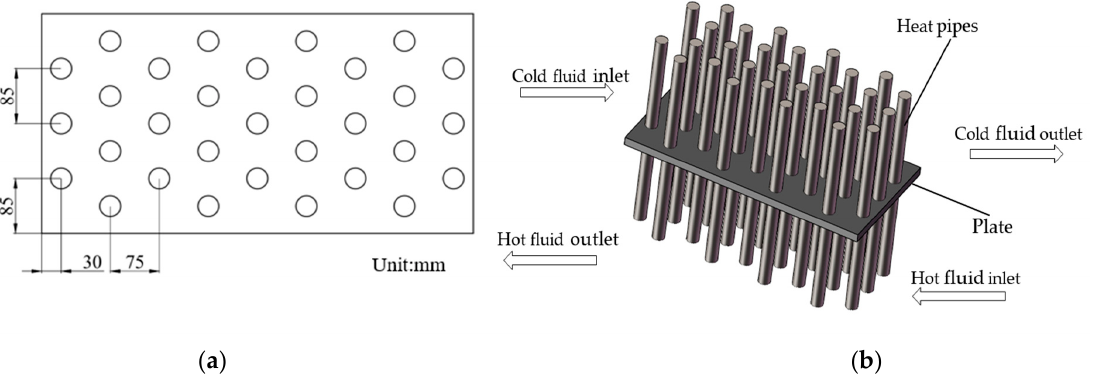
Figure 4. ( a ) Schematic diagram of HPs distribution. ( b ) The structure diagram of the integral HPHEX and the way of inlet and outlet of hot and cold fluid. Table 1. The main parameters of heat pipe heat exchanger.